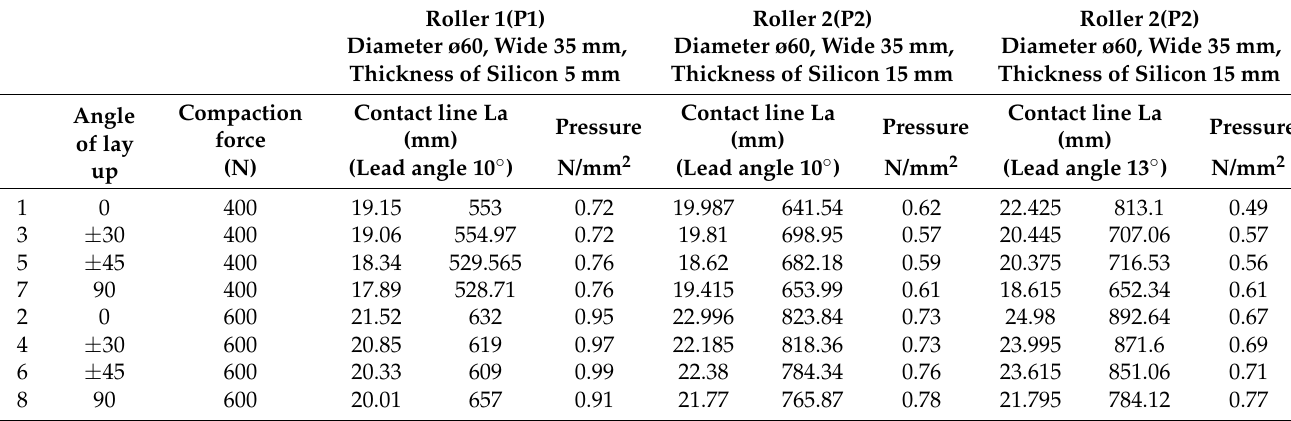
Figure 4. Production of composite flat pallets with LATP technology. Table 2. The value of contact line (La) for different rollers, lead angle and angle of